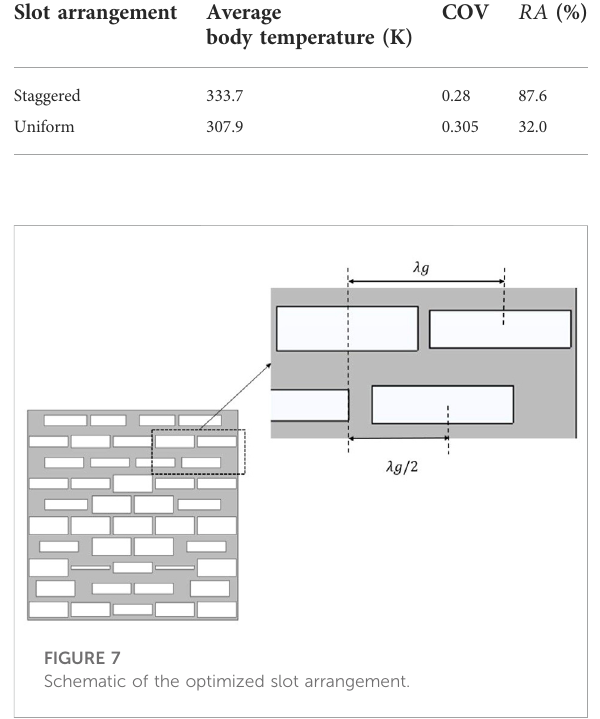
FIGURE 7 Schematic of the optimized slot